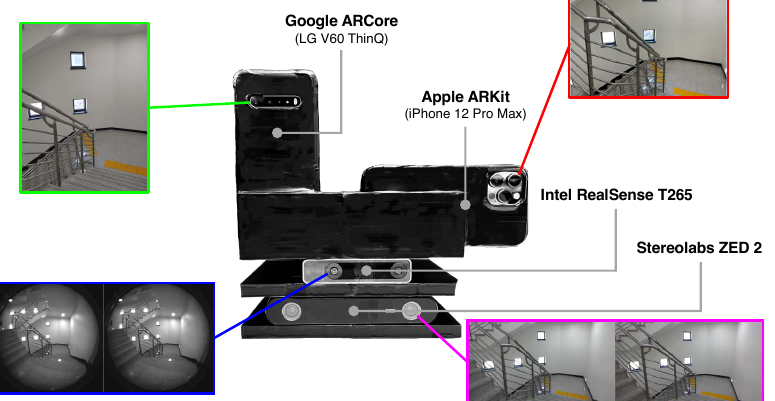
Figure 1. The custom-built rig for benchmarking the 6-DoF motion-tracking performance of four visual–inertial (VI) sensors: Apple ARKit (iPhone 12 Pro Max), Google ARCore (LG V60 ThinQ), Intel RealSense T265, and Stereolabs ZED